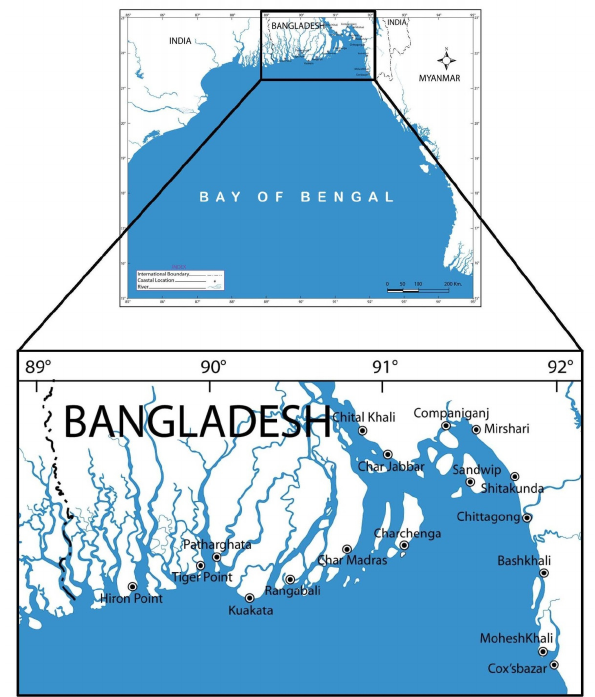
Figure 1. The Bay of Bengal